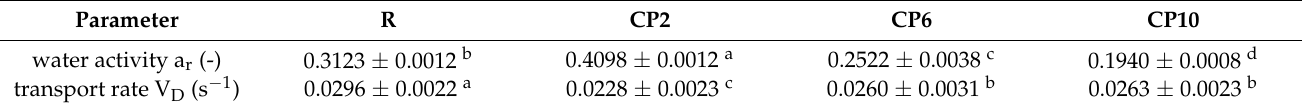
Table 7. Results of water activity in biscuits.